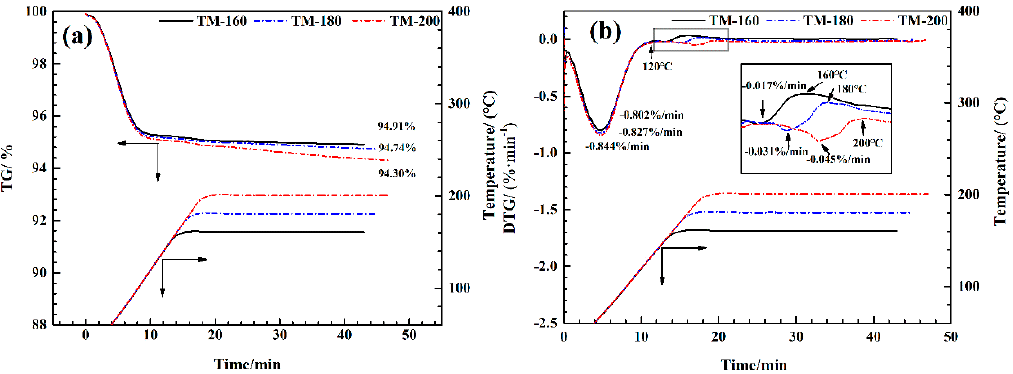
Figure 9. TG ( a ) and DTG ( b ) curves of thermal modification process the wood.